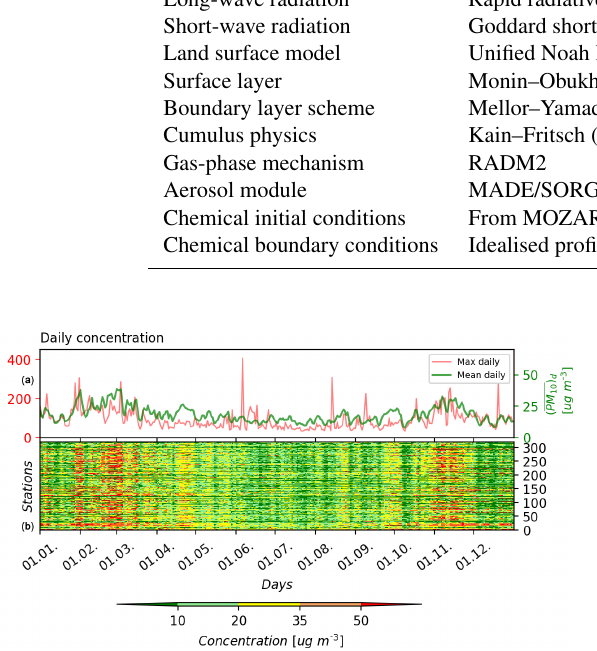
Figure 2. The spatial average (a) over all the rural background sta- tions (the green line, corresponding to the right green y axis) and the maximum of ( PM 10 ) d for all rural background stations (the red line, corresponding to the left red y axis) and ( PM 10 ) d (b) during 2011. The values above 50µgm − 3 (red colour) represent values above the daily limit values for PM 10 under the 2008/50/EC